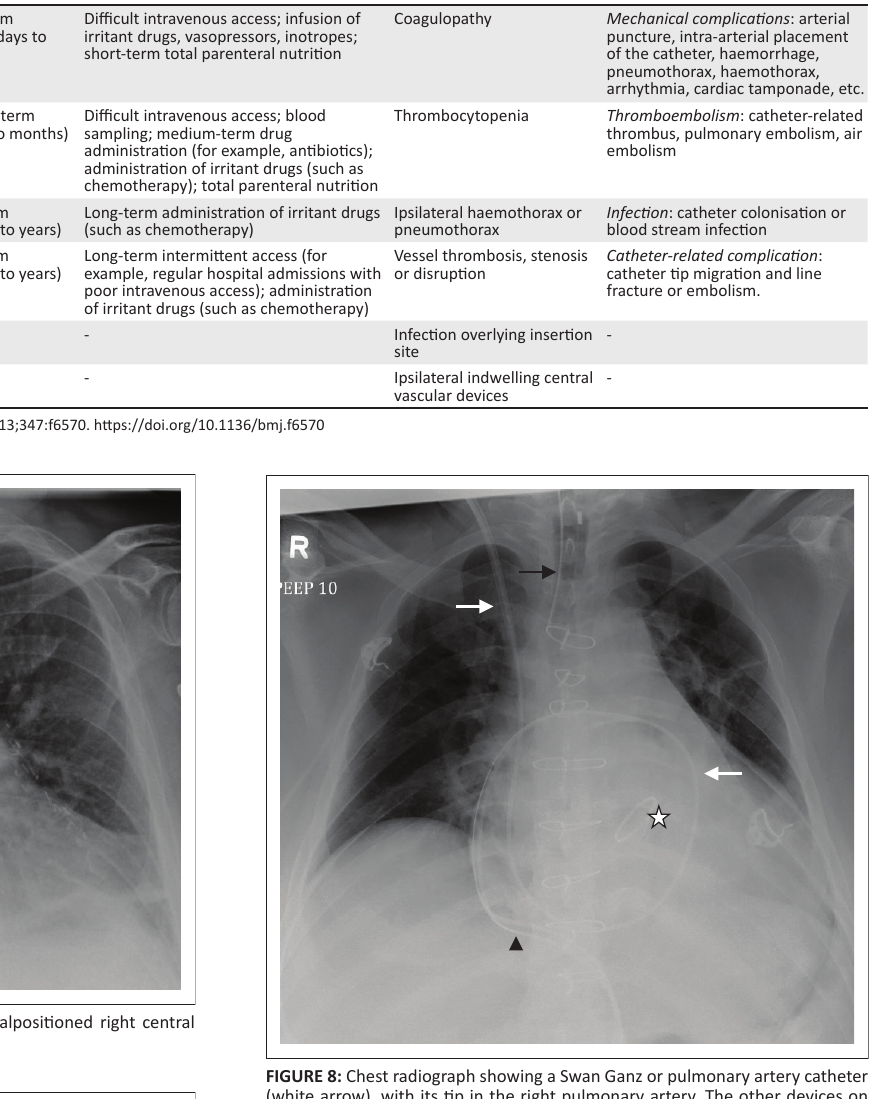
TABLE 1: A summary of the various central venous catheters, potential contraindications and complications. 12 Type of line